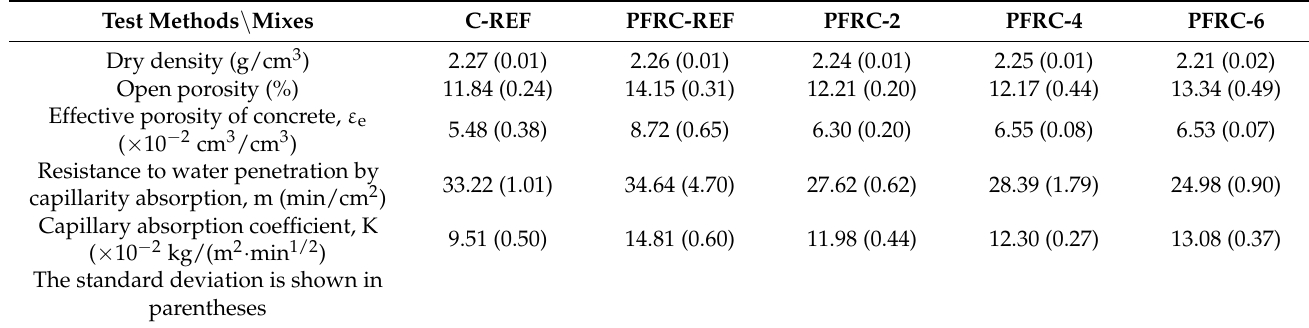
Table 2. Results of the test methods conducted on concrete samples, related to their physical properties. Test Methods \